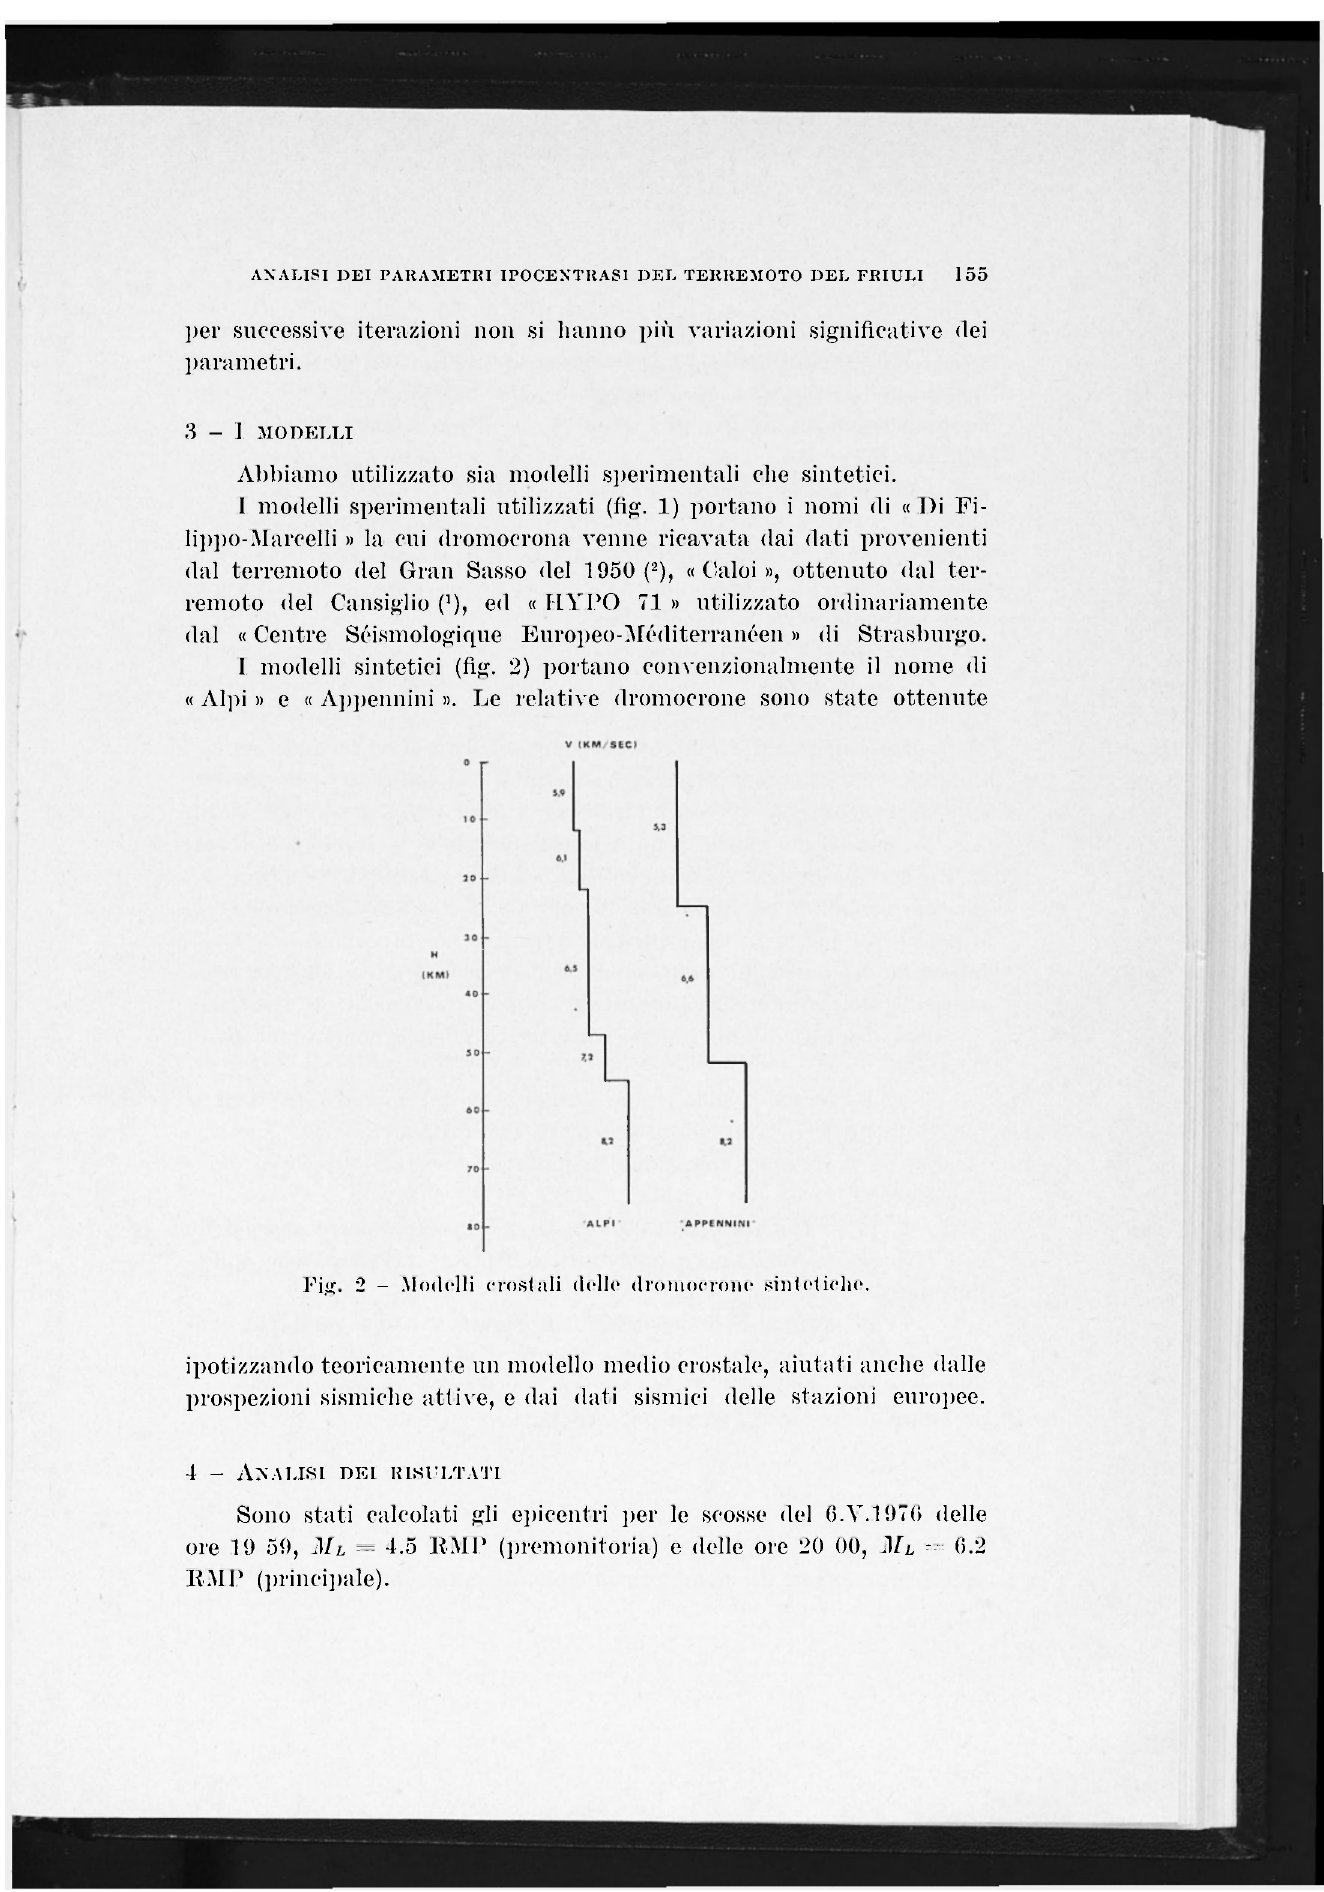
Fig. 2 - Modelli crostali delle dromocrone